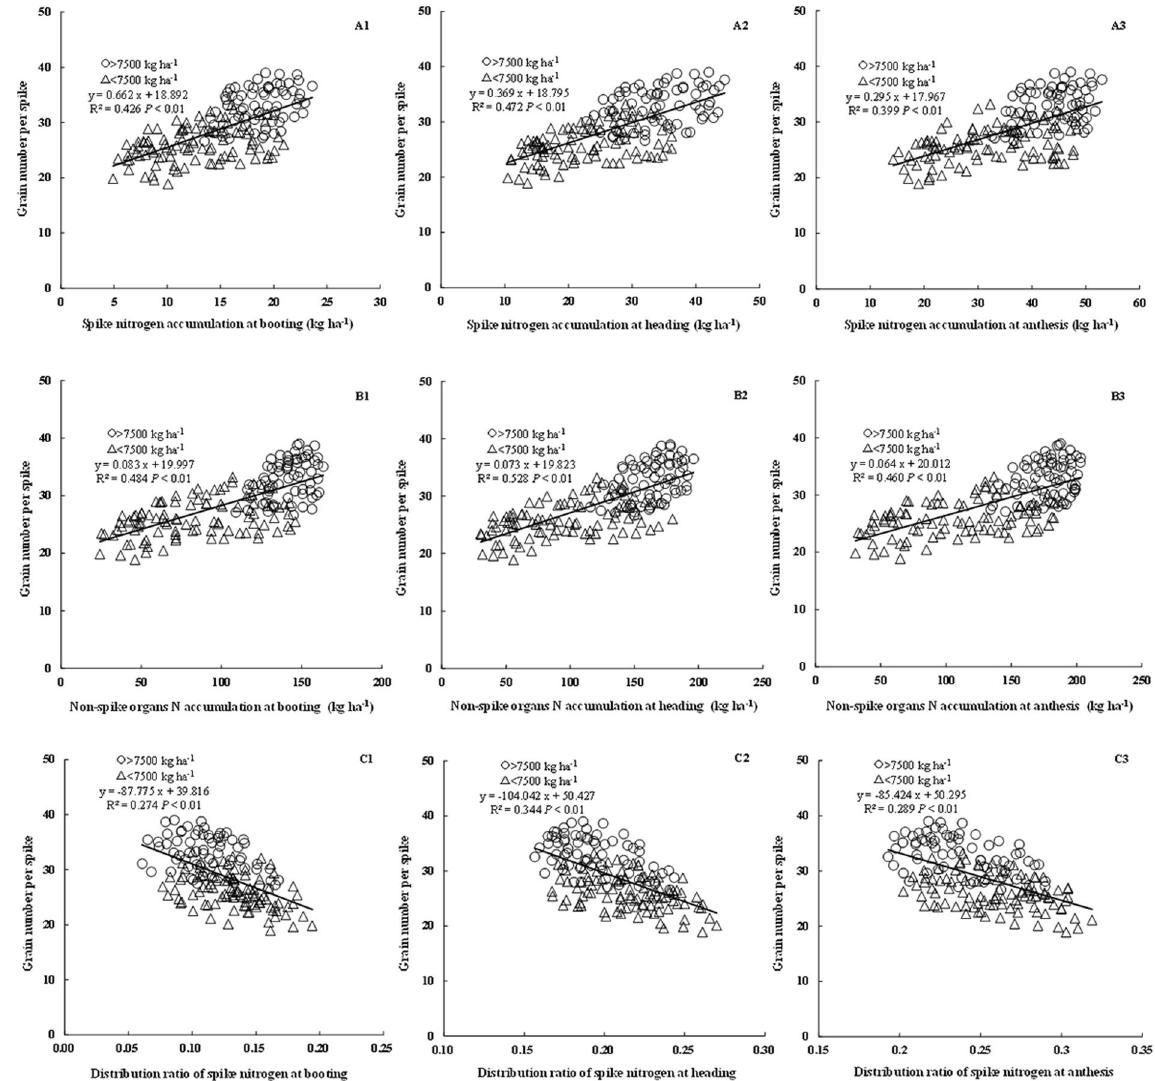
Figure 4. Relationship between grain number per spike and spike N accumulation, non-spike organs N accumulation and the distribution ratio of spikes in total aboveground N accumulation during booting, heading and anthesis